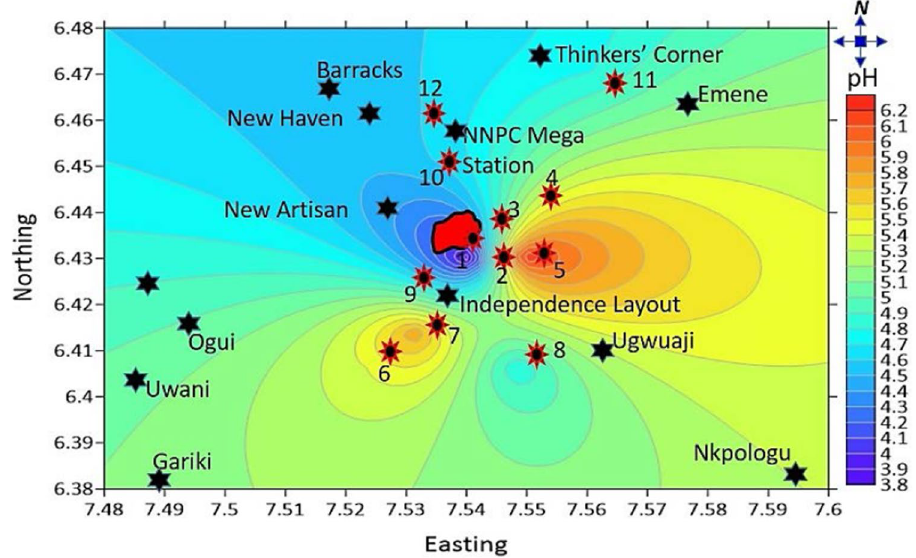
Fig. 8 Contour plot of pH val- ues of the tested water